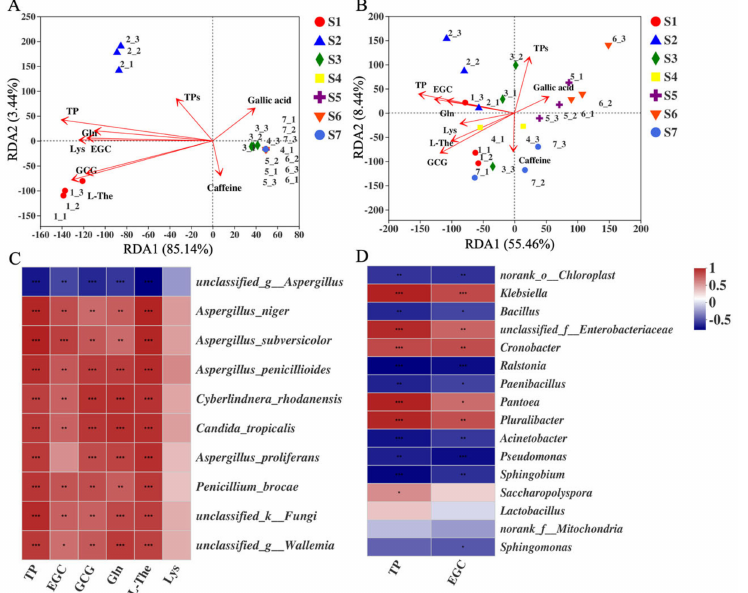
Figure 7. Correlations between microorganisms and metabolites during the processing and storage of Fu brick tea. ( A ) Redundancy analysis (RDA) shows the correlation between the 9 critical metabolites and seven FBT samples, based on fungal OTUs, and ( B ) bacterial OTUs. ( C ) Heat map analysis the correlation between critical metabolites with important fungal species and ( D ) bacteria